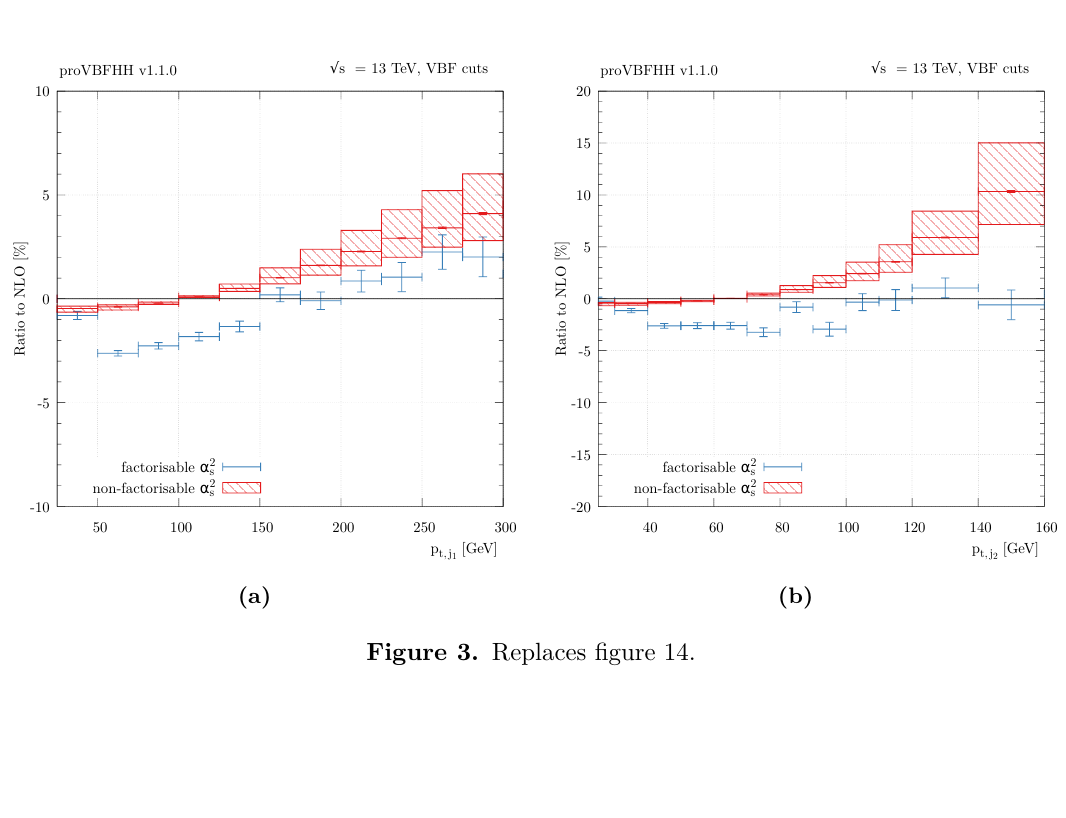
Figure 3. Replaces figure